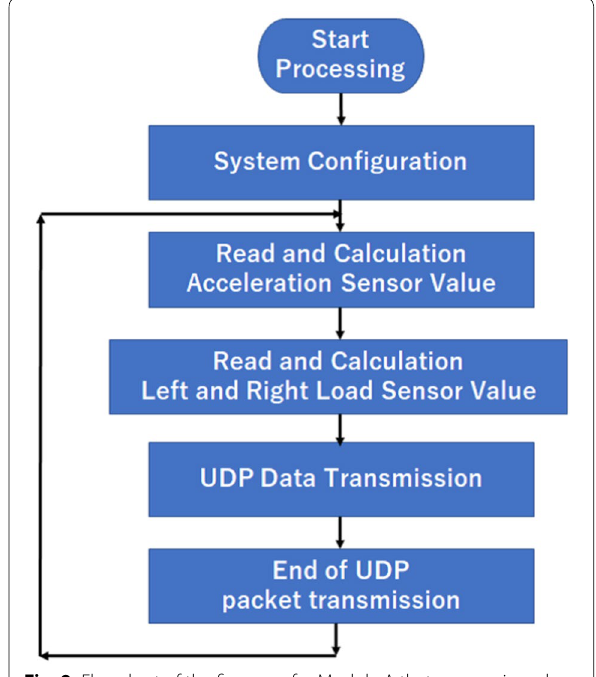
Fig. 9 Flowchart of the firmware for Module A that was equipped with load sensors for left and right upper limb load measurements and an acceleration sensor